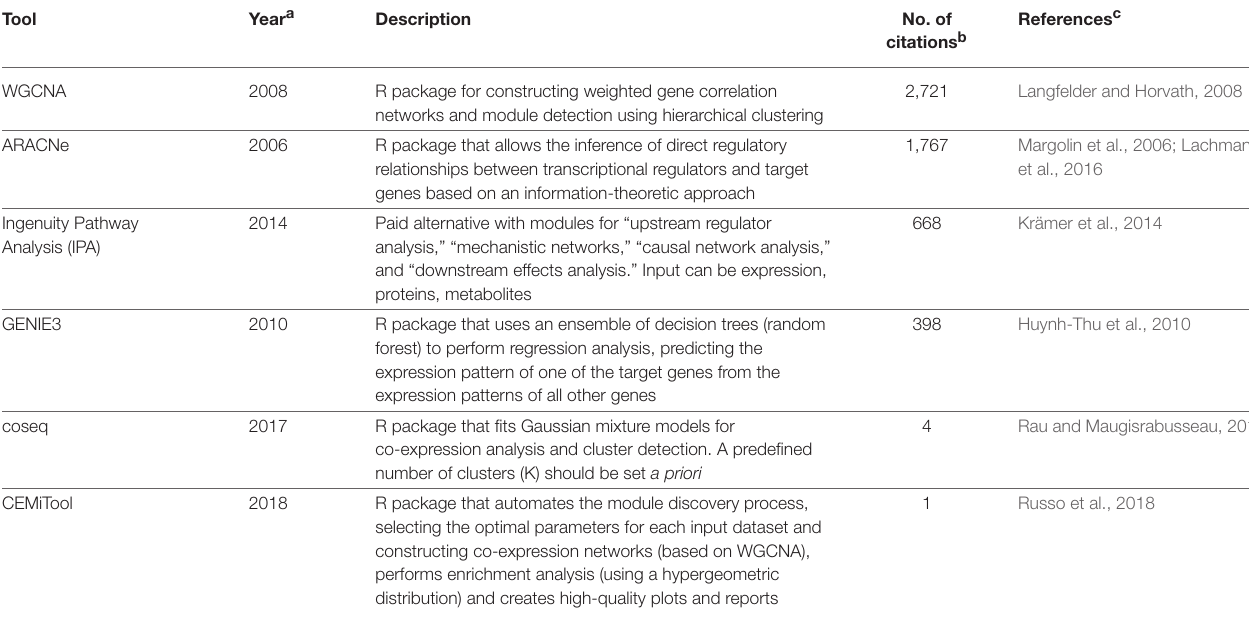
TABLE 3 | Computational tools for inferring co-expression and regulatory patterns in omics